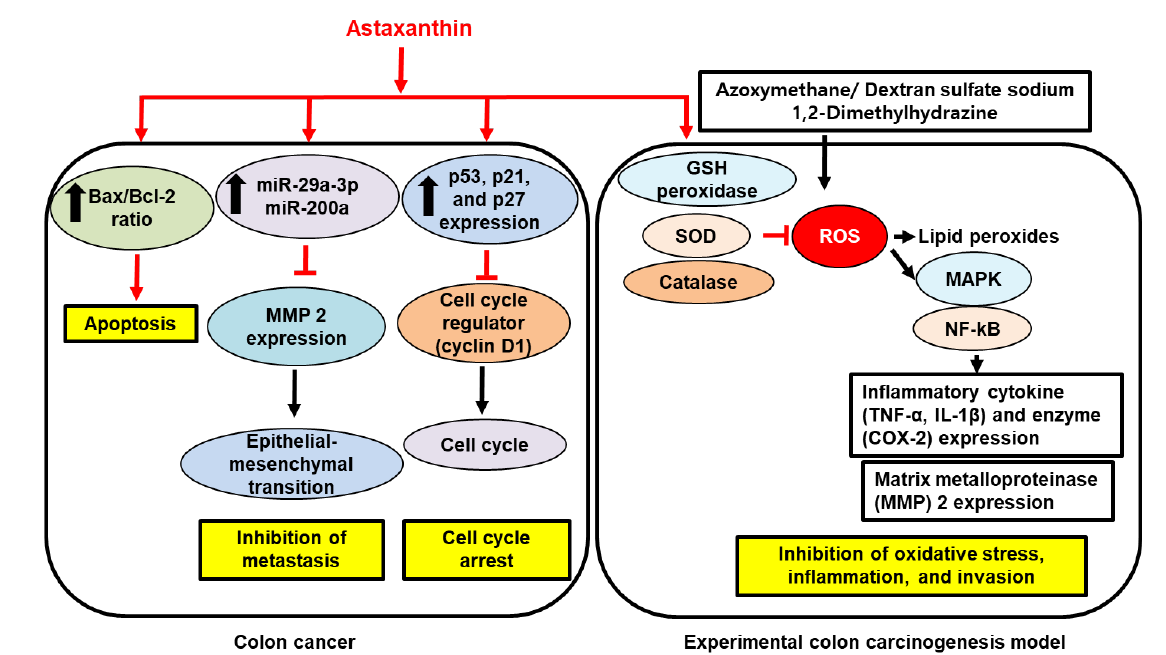
Figure 4. The inhibitory effect of astaxanthin on proliferation, metastasis, and oxidative stress- mediated inflammation and invasion in colon cancer development and progression. In colon cancer cells, astaxanthin increases Bax/Bcl-2 ratio, resulting in apoptosis. Astaxanthin increases micro RNA (miR)-29a-3p and miR-200a which inhibits matrix metalloproteinase (MMP) 2 expression that mediates epithelial-mesenchymal transition. Astaxanthin stimulates expression of tumor suppressor p53, p21, and p27 that inhibits the expression of cell cycle regulator cyclin D1, leading to cell cycle arrest. In experimental colon carcinogenesis model, induced by treatment of azoxymethane/dextran sulfate sodium or 1,2 dimethylhydrazine, astaxanthin increased glutathione (GSH) peroxidase, superoxide dismutase (SOD), and catalase which reduces reactive oxygens species (ROS) and production of lipid peroxides. Thus, astaxanthin suppresses ROS-mediated activation of mitogen-activated protein kinases (MAPK) and nuclear factor- κ B (NF- κ B) and inhibits expression of inflammatory cytokines tumor necrosis factor- α (TNF- α ) and interleukin (IL)-1 β , inflammatory enzyme cyclooxygenase-2 (COX-2), and MMP2. Therefore, astaxanthin inhibits inflammation and invasion by reducing ROS levels in the pathogenesis of colon cancer development. Inhibit, ; increase, . Red arrows represent the effects of astaxanthin. 6. Conclusions In this review, the anti-oxidative and anti-inflammatory properties of AST have been highlighted in various experimental models of GI ulcers and cancers. Locating at the